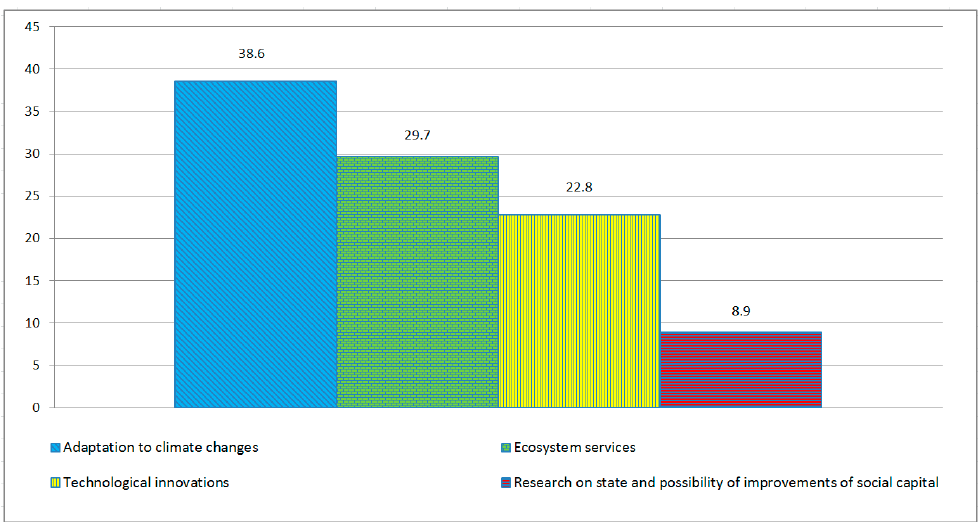
Figure 4. Hierarchy of research areas based on AHP method (% of total number of points). Source: Study results.